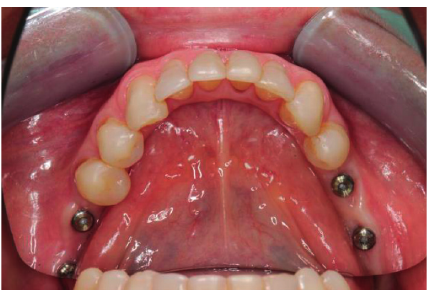
Figure 11: Placement of gingiva formers.